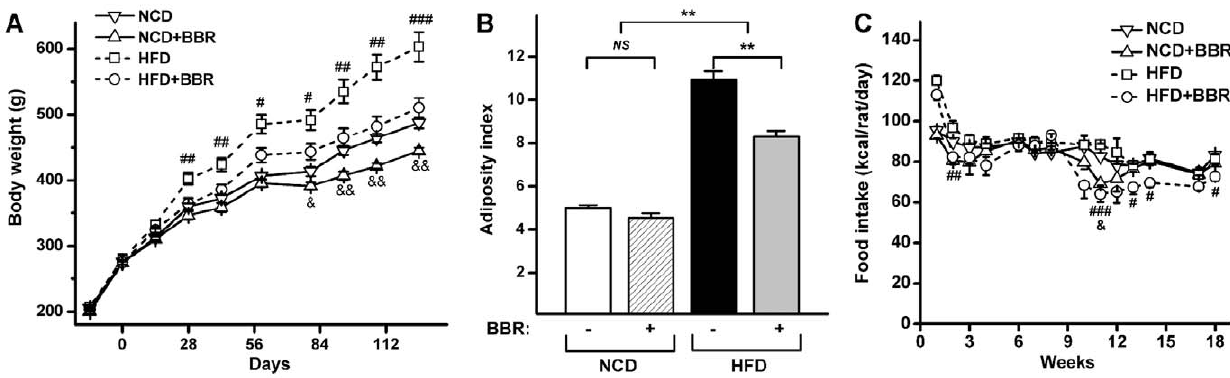
Figure 1. Effects of berberine on body weight gain, the adiposity index and food intake in HFD-fed rats. (A) Body weight gain; (B) adiposity index, calculated as the fat pad weight (sum of epididymal and perirenal fat pads) per 100 g of total body weight; (C) food intake. Values are expressed as means 6 standard error. Differences were assessed by ANOVA and denoted as follows: # P , 0.05, ## P , 0.01, ### P , 0.001, HFD vs. HFD + BBR; & P , 0.05, && P , 0.01, NCD vs. NCD + BBR; ** P , 0.01; NS not significant.